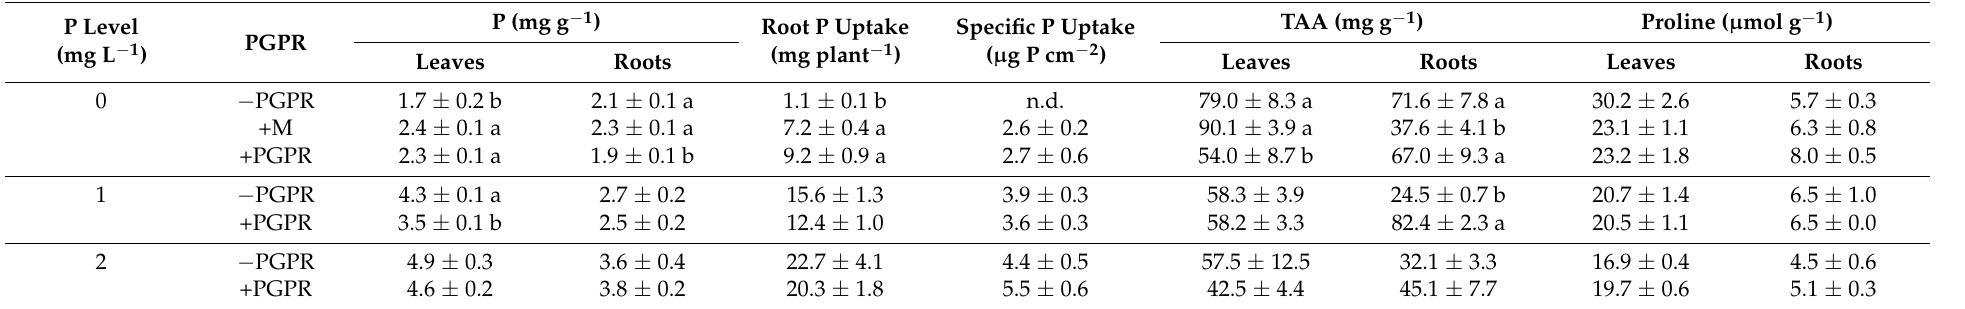
Table 2. Effect of PGPR on P, root P uptake, specific P uptake, total free amino acids (TAA), and proline concentrations in young leaves and roots at low P